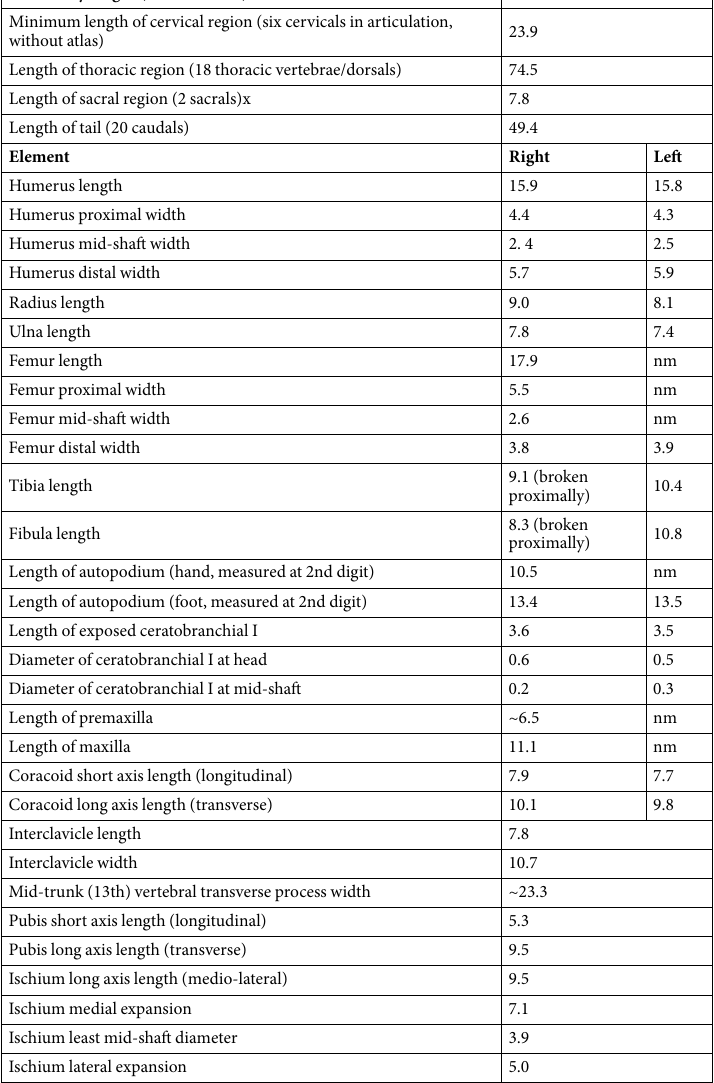
Table 1. Measurements of PIMUZ A/III 4380 in [mm], rounded to the first decimal place. Abbreviations: nm = not